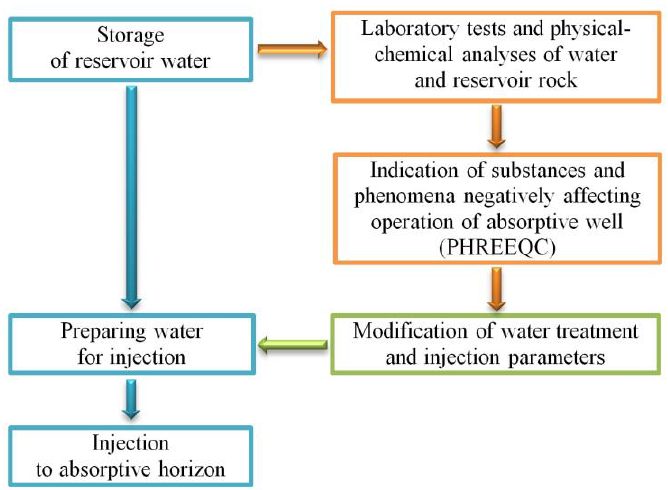
Figure 1. Scheme of water injection process with necessary laboratory and modelling research.